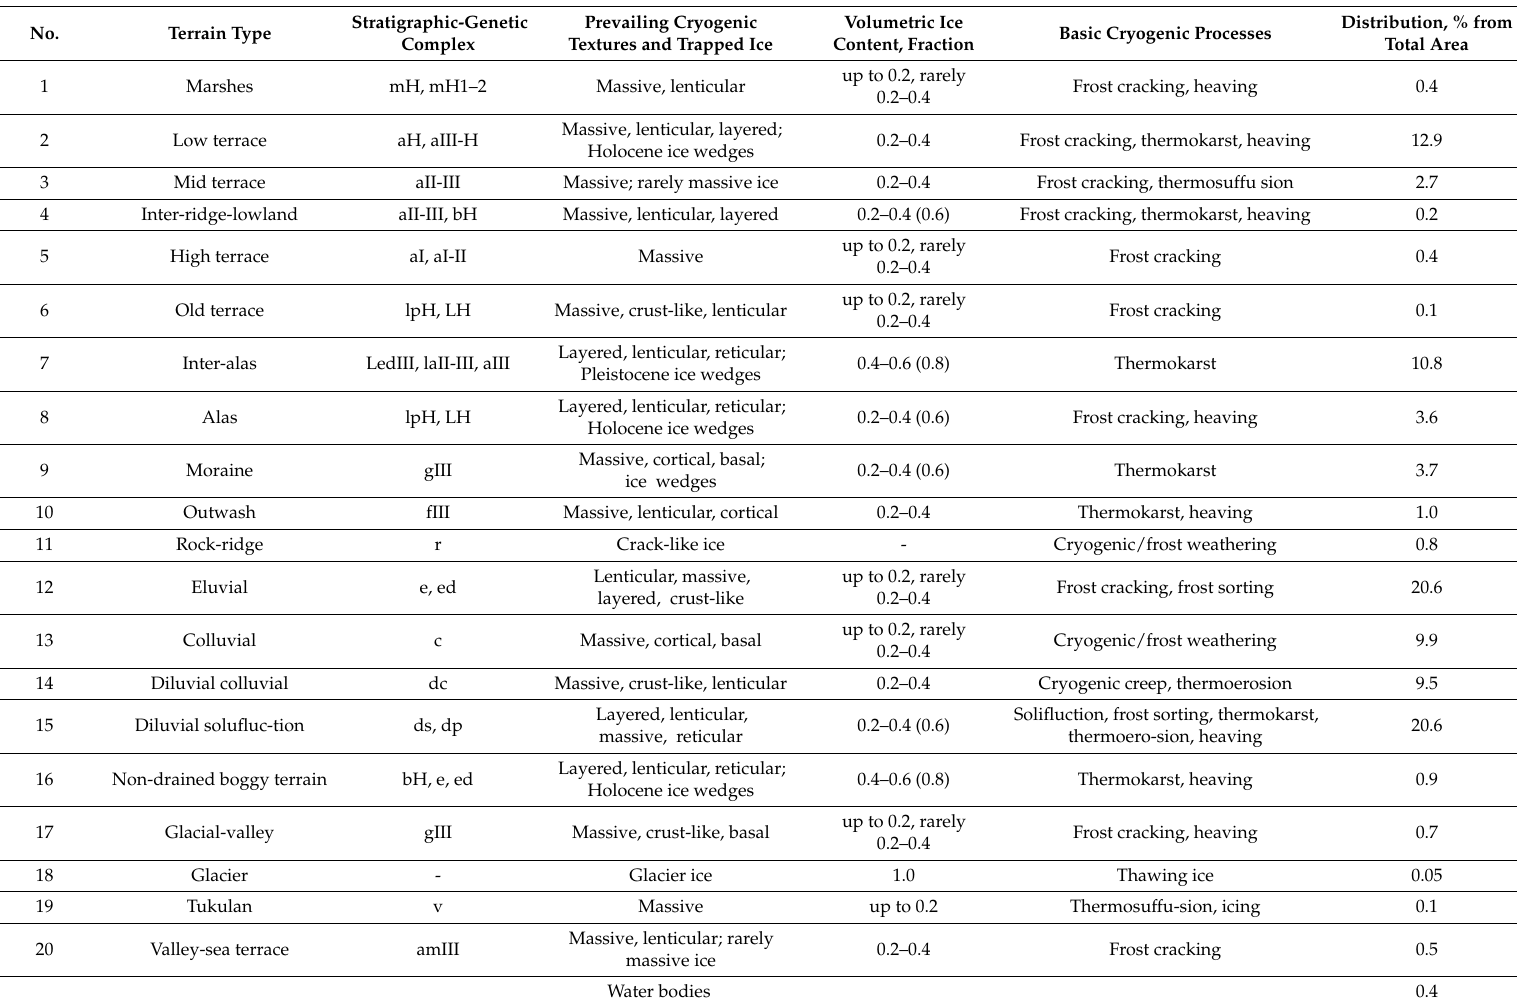
Table 1. Terrain types distribution in